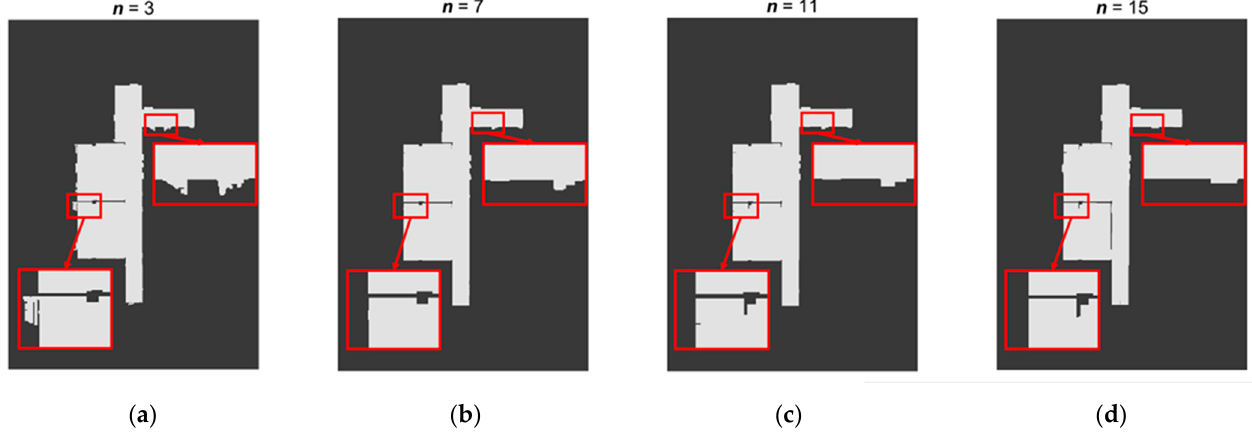
Figure 5. The final binary masks obtained using various values of the SE size n. ( a ) n = 3, ( b ) n = 7, ( c ) n = 11, and ( d ) n = 15.